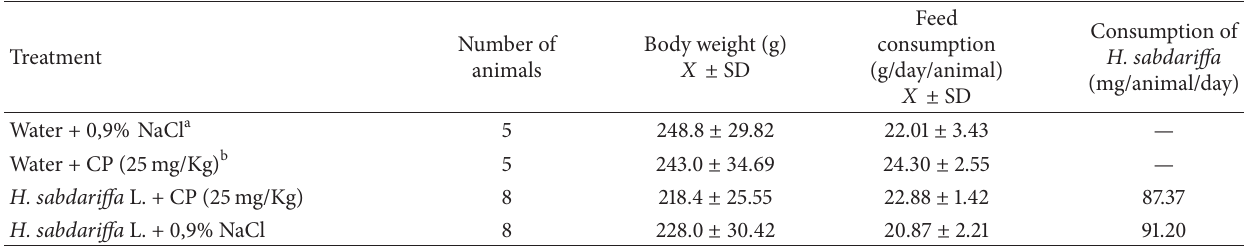
Table 3: Average feed intake and H. sabdariffa L. (dry weight) for rats treated for 15 days with the aqueous extract of H. sabdariffa or